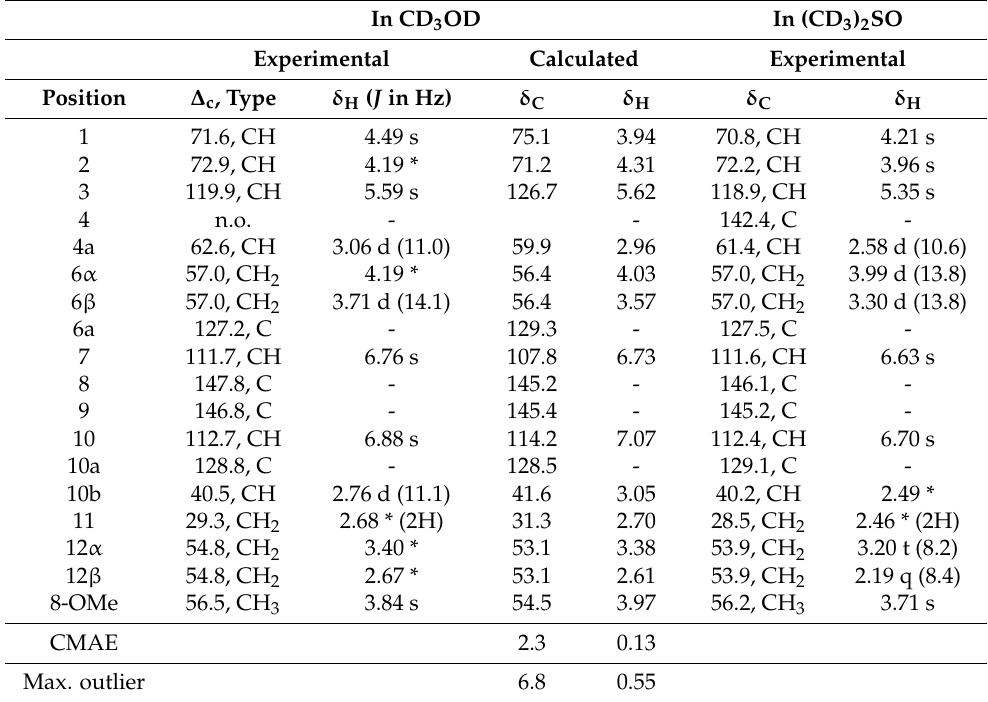
Table 4. Experimental and computed NMR spectroscopic data (400 MHz, CD 3 OD and (CD 3 ) 2 SO for ( ± )-2- epi -pseudolycorine ( 2 and 3 ). In CD 3 OD In (CD 3 ) 2 SO Experimental Calculated Experimental